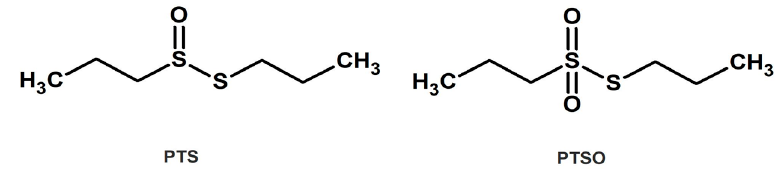
Figure 1. Chemical structure of PTS and PTSO.